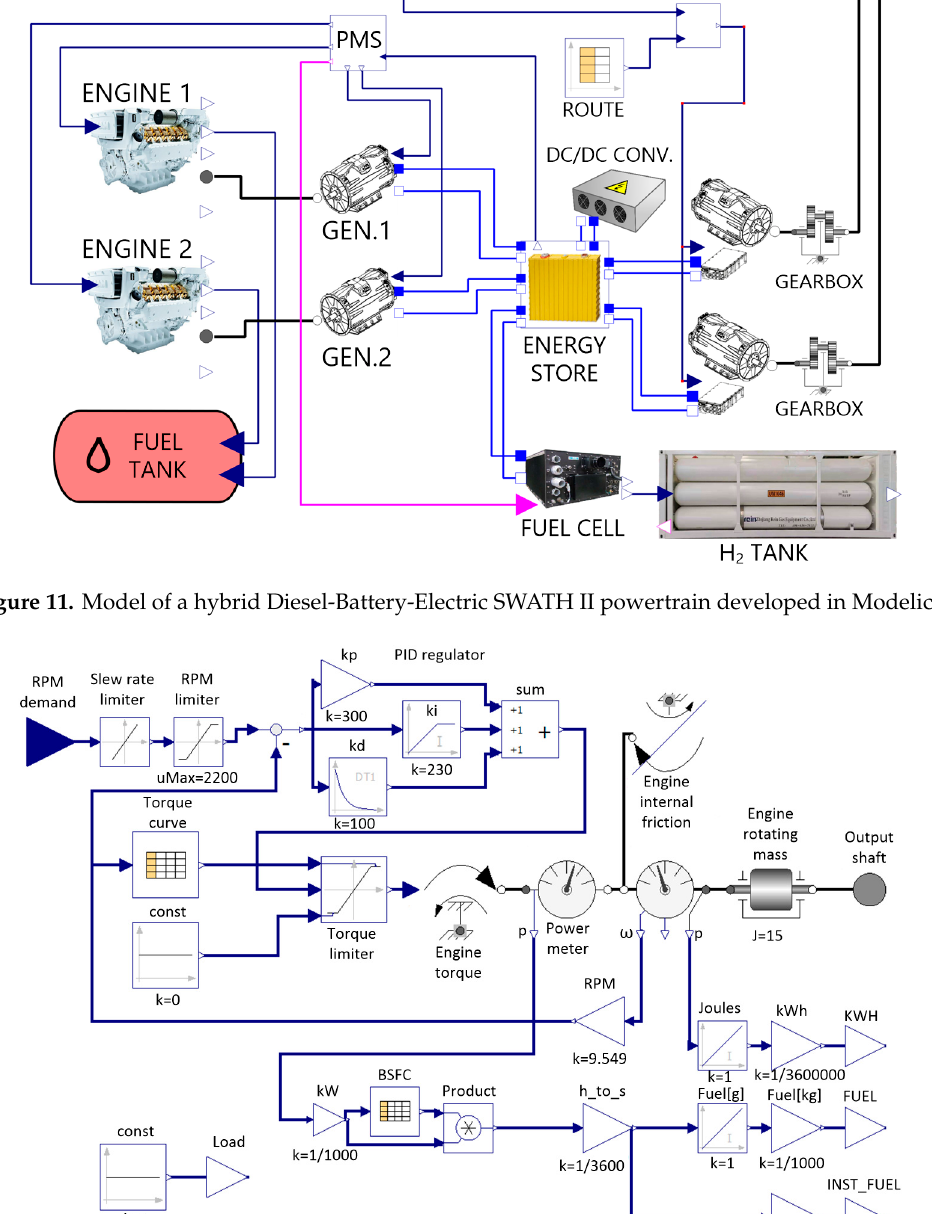
Figure 13. MAN V12-1650 engine curves [53].